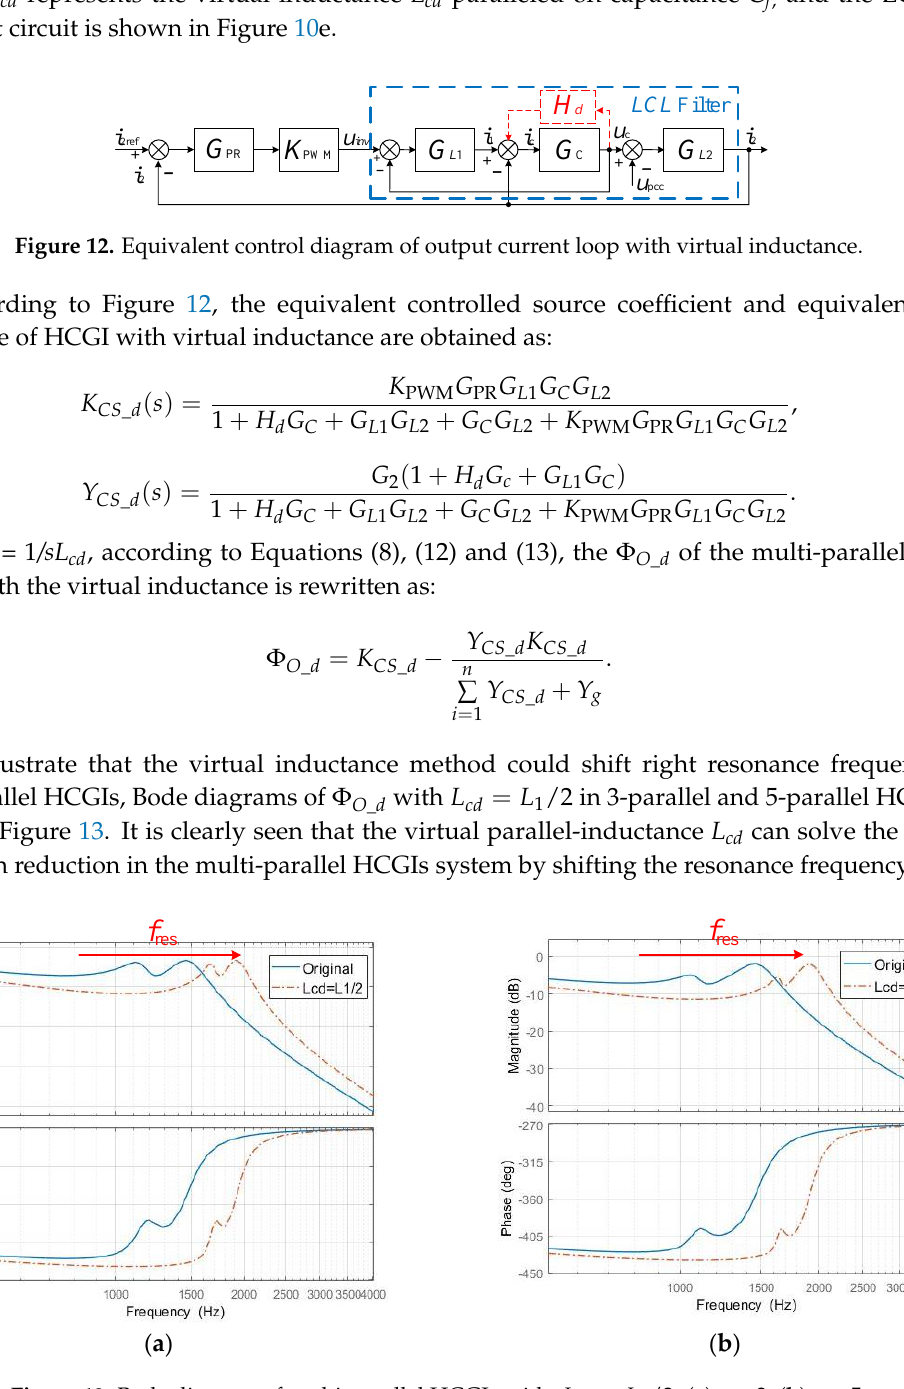
= L 1 /2. ( a ) n = 3; ( b ) n = cd